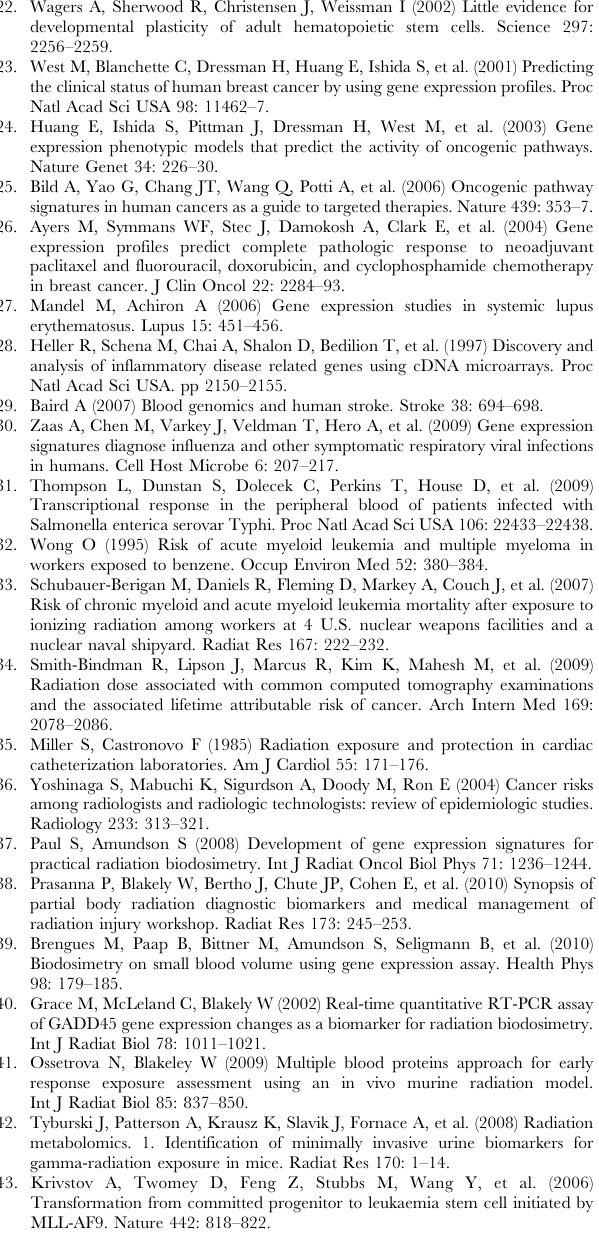
Table S3 Overlapping genes between TBI and Partial Body